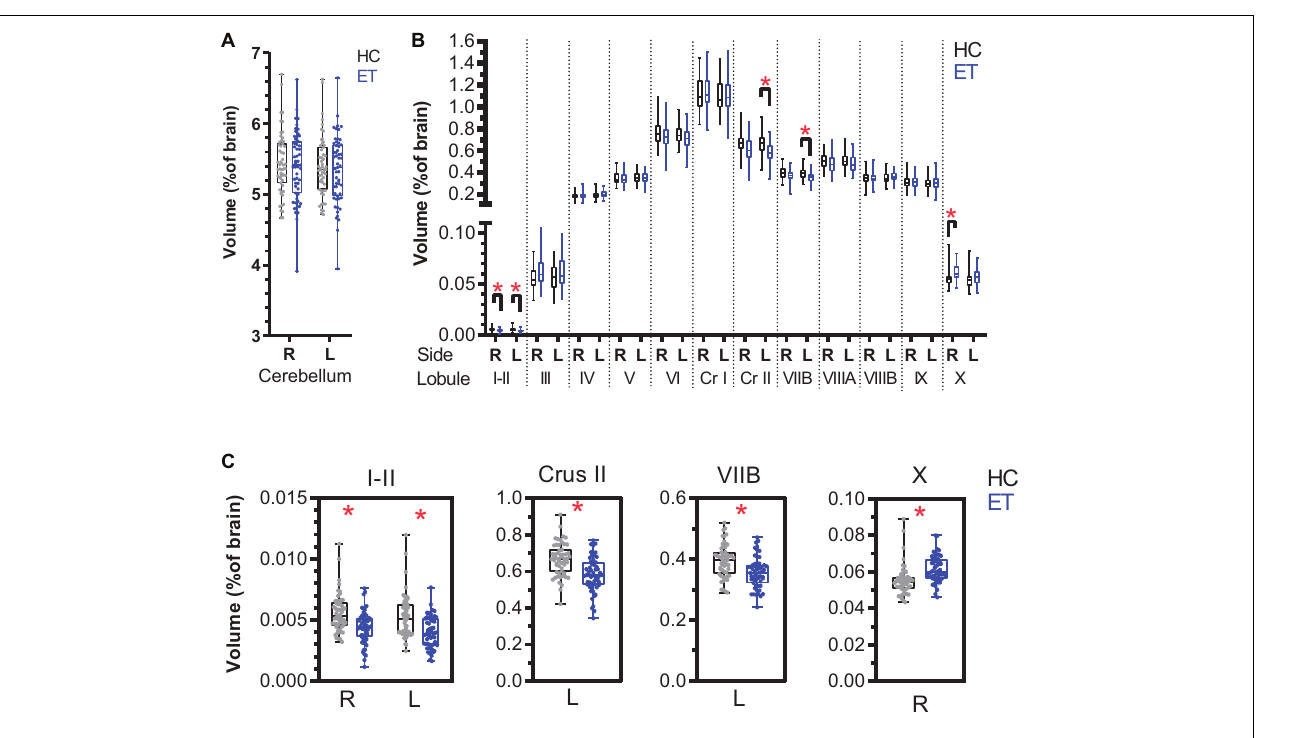
covariates. Total cerebellar volumes did not differ (right: p = 0.874 and left: p = 0.995, Figure 2A ) between the groups, while volumes of lobules I-II (right: p < 0.001 and left: p < 0.001), left Crus II ( p < 0.001), and left VIIB ( p < 0.001) were lower in the ET group than in the HC group ( Figures 2B,C and Table 2 ). The